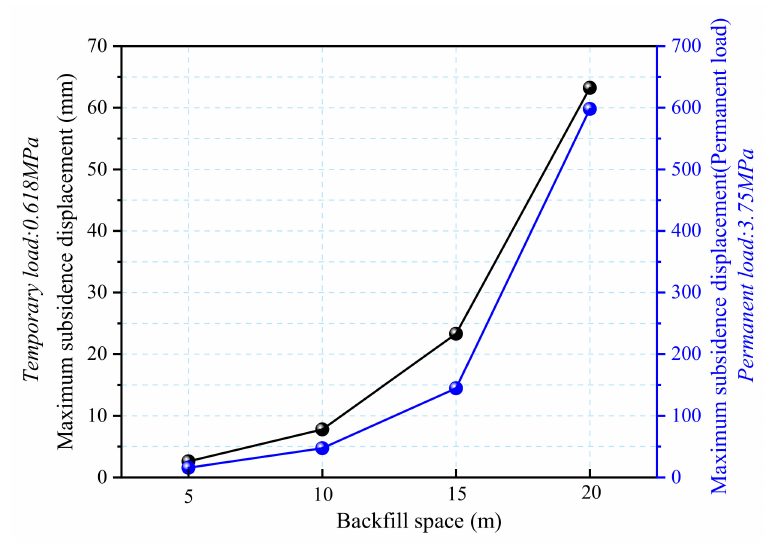
Figure 11. Wall spacing-maximum settlement of the